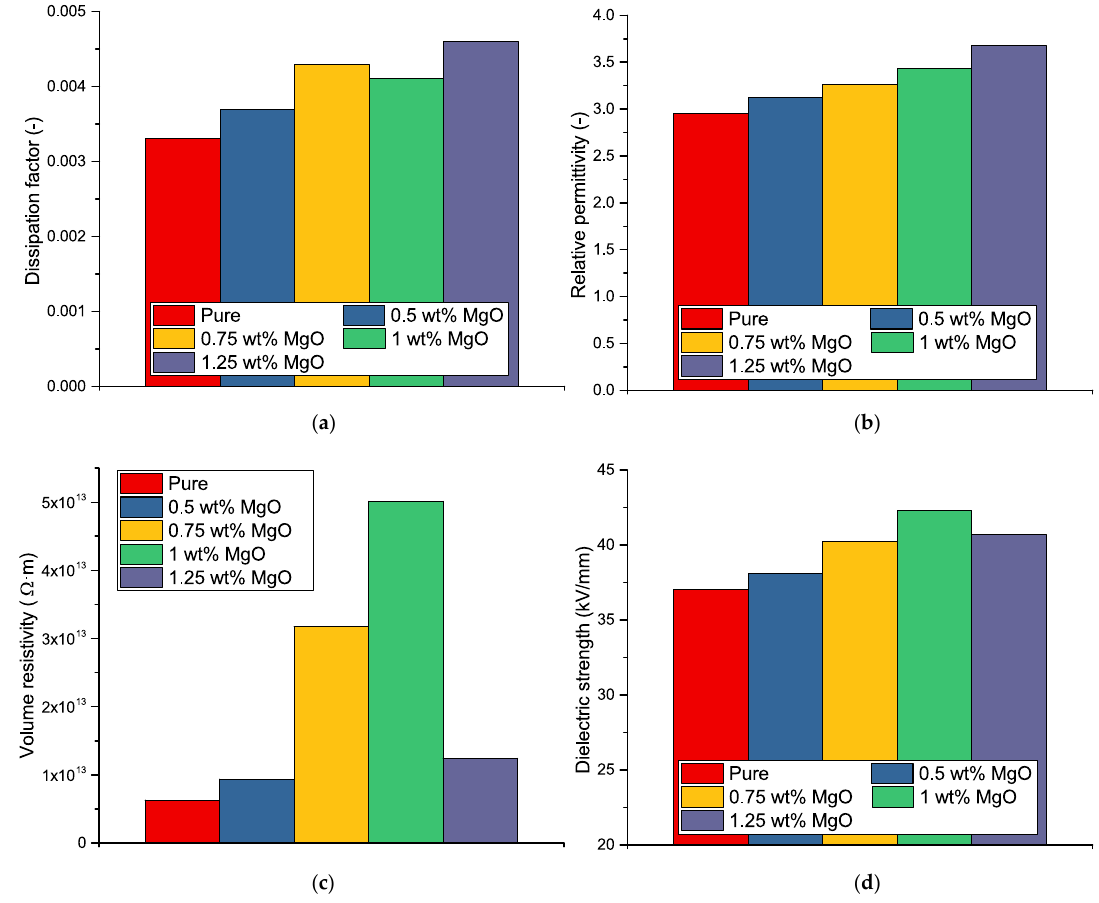
Figure 4. Changes of dielectric properties depending on the filler amount. ( a ) dissipation factor—500 V AC, 50 Hz; ( b ) relative permittivity—500 V AC, 50 Hz; ( c ) Volume resistivity—500 V DC; ( d ) Dielectric strength—increase 1.5 kV/s